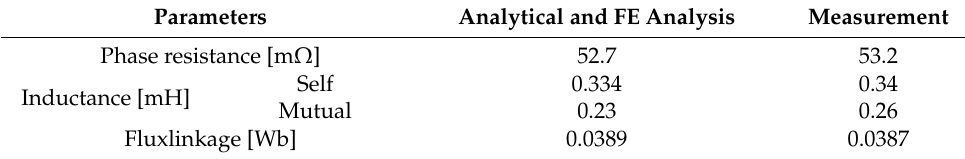
Table 2. Electrical circuit parameters of the